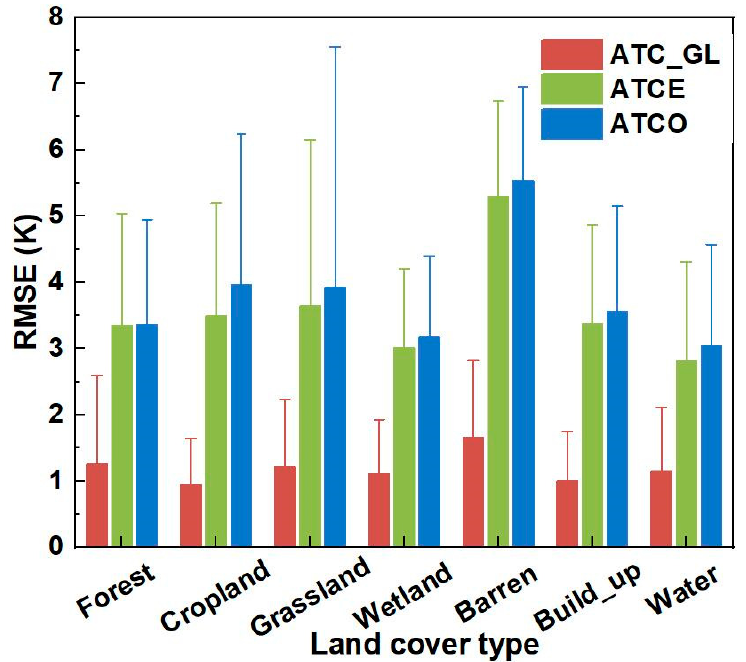
Figure 6. The RMSEs of the ATC_GL, ATCE, and ATCO according to land cover type. The ATC_GL had the highest accuracy for all land cover types (Table 4). The highest and lowest RMSE for the ATC_GL was estimated in barren land (1.8 K) and cropland (0.9 K), respectively. The RMSEs of the ATCE and ATCO were relatively similar (Table 4); both the ATCE and ATCO showed maximum RMSEs in barren land (5.3 K and 5.9 K, respectively) and minimum RMSEs over water bodies (2.8 K and 3.3 K, respectively). The pronounced differences in RMSE between the land cover types for the ATCE and ATCO (more than 2.0 K) indicate that the performance of the ATC_GL (less than 0.9 K) remained relatively stable. The accuracy improvement of the ATC_GL was the highest in barren areas (exceeding 3.5 K), while there were relatively lower accuracies for forests, wetlands, and water bodies (more than 1.5 K; Table 4). The R 2 of the ATC_GL (exceed 0.94) was significantly higher than that of the ATCE (0.86–0.92) and the ATCO (0.87–0.94). A smaller RMSE usually corresponds to a larger R 2 for various land cover types. This result may reflect that the magnitude of the accuracy improvement depends on the LST fluctuation magnitude of the ATC_GL method. The improvement is relatively small where LSTs keep relatively stable, such as in forest, wetland and water body, probably because the ATCE and ATCO can achieve high accuracy in these areas [19]. On the contrary, the improve ‐ ment is relatively higher where LSTs have high variations [56–58]. That is because the ATCE and ATCO have poor performance in such areas, while the ATC_GL can better reflect the spatial variations of LSTs in these areas by incorporating spatially local infor ‐ mation. Table 4. The performances of the ATC_GL, ATCE, and ATCO over different land cover types. RMSE (K)